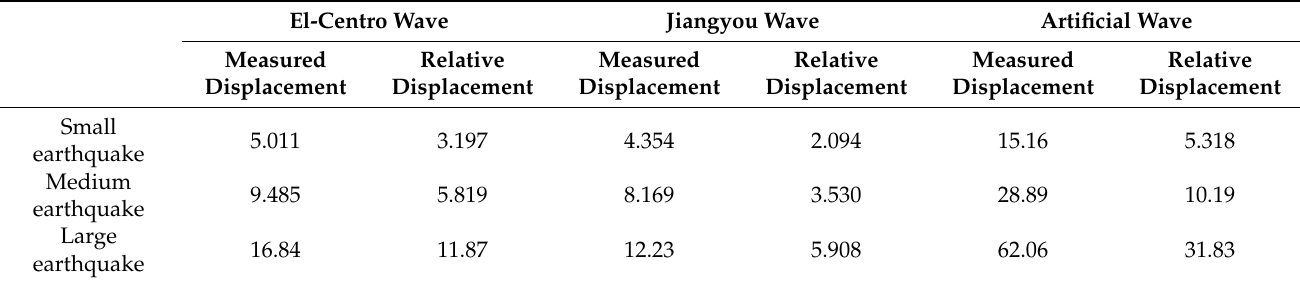
Table 6. The maximum relative displacement of the top floor of the tower with control condition under 8-degree earthquakes (mm).